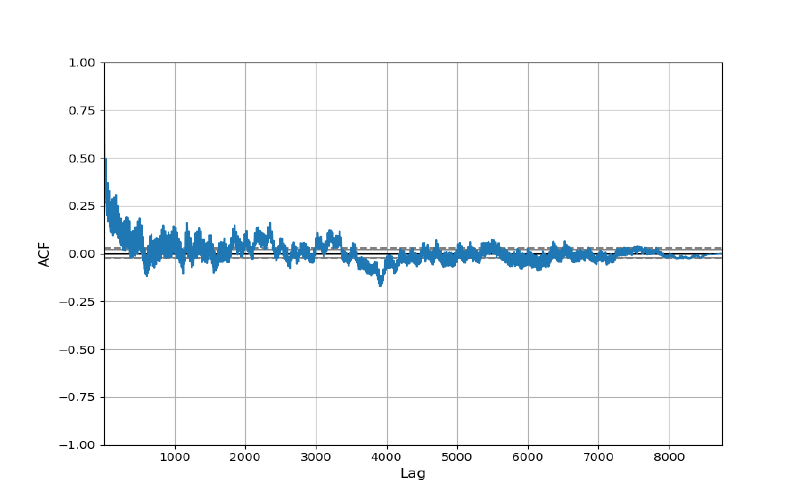
Figure 6. Sample autocorrelation function of hourly values for NO 2 concentrations from Blanchardstown air quality monitoring station. Software: Python